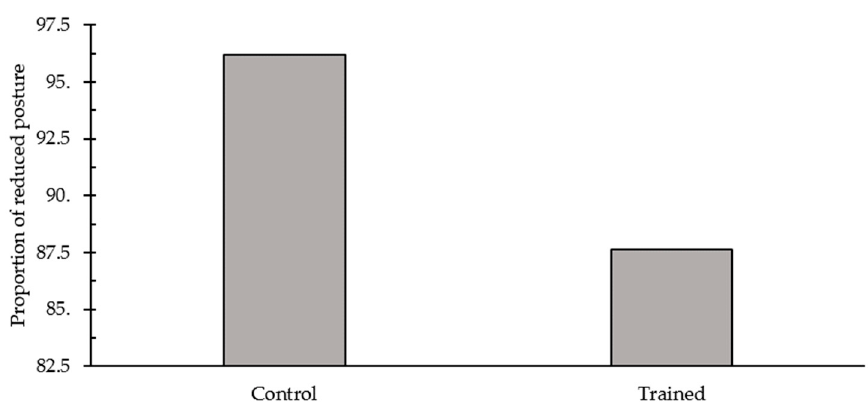
Figure 3. A higher proportion of control dogs (96.2%) displayed reduced posture during the examination compared to trained dogs (87.6%).